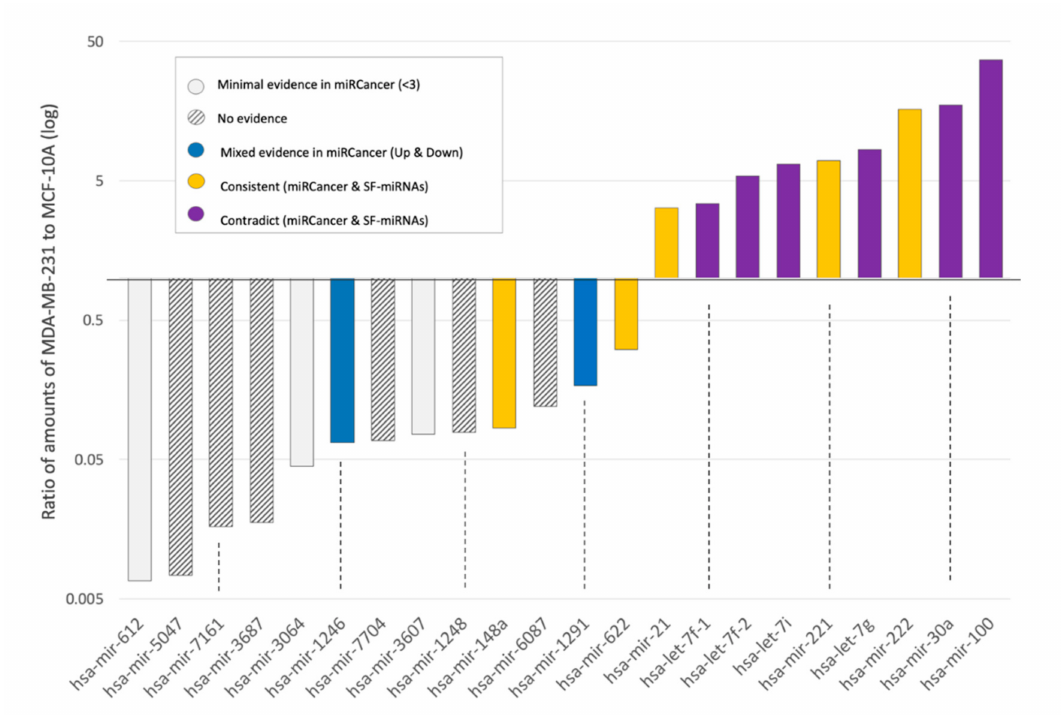
Figure 8. Expression level of SF-miRNAs in breast cancer cell-lines with respect to miRCancer annotations. Ratio of expression of SF-miRNAs in MDA-MB-231 to MCF-10A (log scale). A total of 22 di ff erentially expressed SF-miRNAs are listed with a minimal expression levels of > 50 reads (sum of MCF-10A and MDA-MB-231 expression reads). The color signifies the comparison according to the consistency with miRCancer (yellow—consistent trend; grey stripes—not available; blue, mixed trend; purple, opposite trend; white, minimal support (defined as miRNA with only 1–2 reported